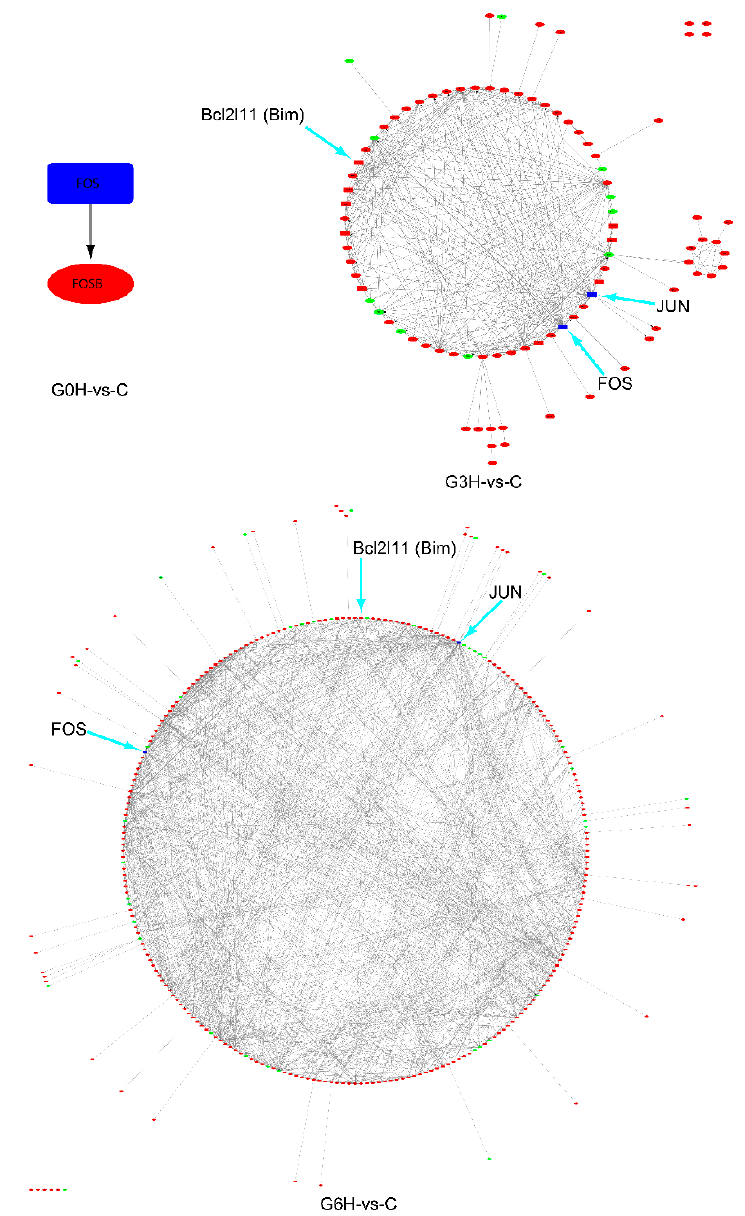
Figure 5. Time series differential expression genes interactions network of the 31 RCD-related genes (not counting ICD-related genes), 2 transcription factors, and corresponding target genes of the transcription factors. Blue nodes represent upregulated transcription factors; red nodes are upregulated genes; green nodes are downregulated genes; round rectangle nodes are RCD-related genes; ellipse nodes are non-RCD-related genes; edges are genes interactions; edge directions are the regulatory interactions from transcription factors to their target genes. Cyan arrowheads indicate amplified gene names on the gene interaction